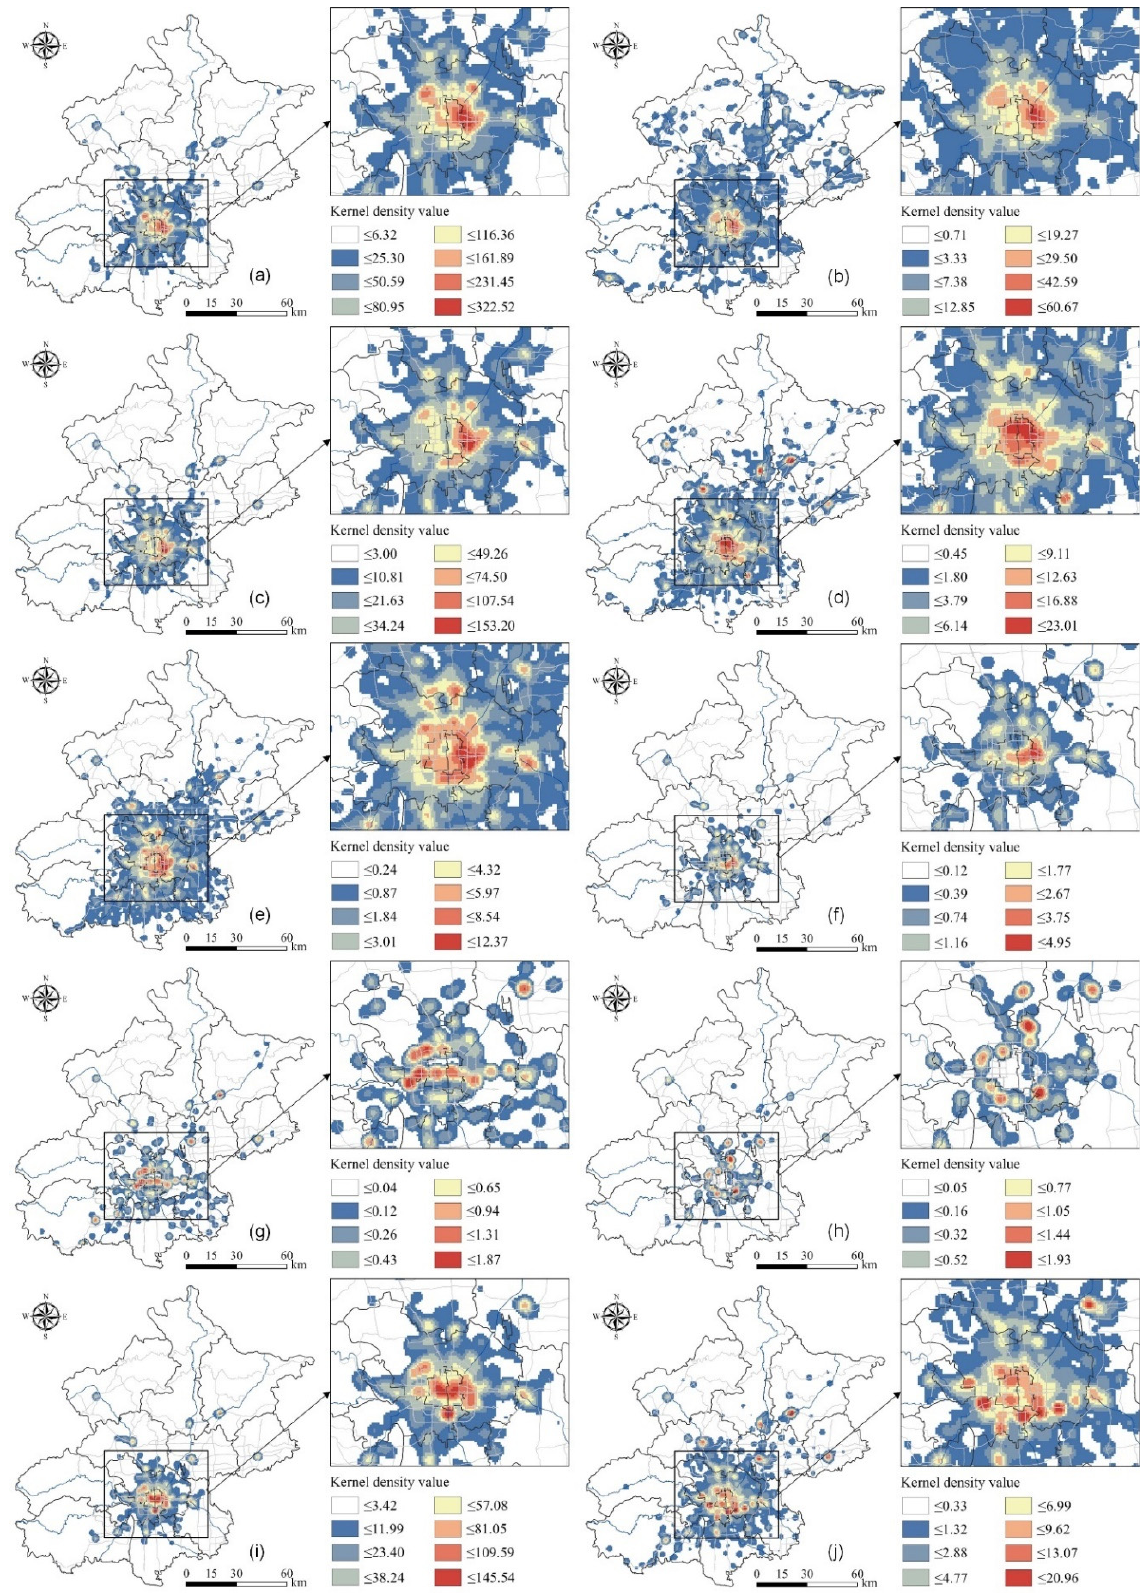
Figure 6. Estimated kernel density of various commercial formats in Beijing: ( a ) catering services, ( b ) recreation and leisure services, ( c ) living services, ( d ) convenience stores, ( e ) supermarkets, ( f ) shopping malls, ( g ) home appliance and electronics stores, ( h ) home building materials markets, ( i ) specialty stores, and ( j ) agricultural markets.